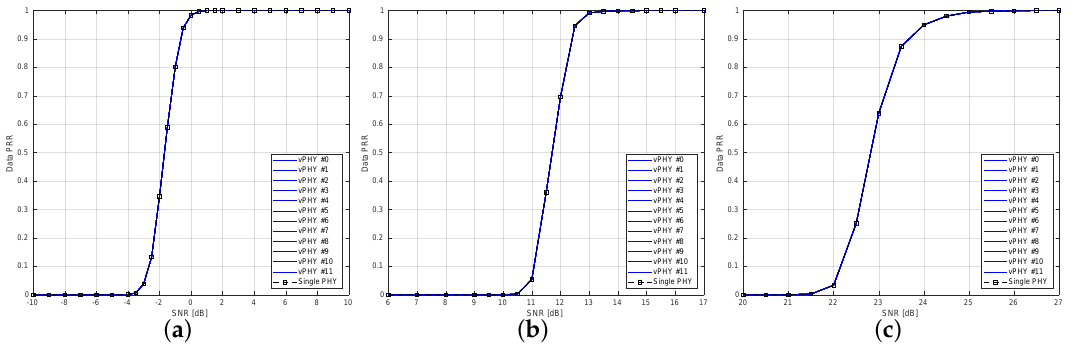
Figure 21. Data PRR curves for a setup with 12 vPHYs with their signals multiplexed by the prototype and using: ( a ) MCS0 (QPSK), ( b ) MCS16 (16QAM), and ( c ) MCS28